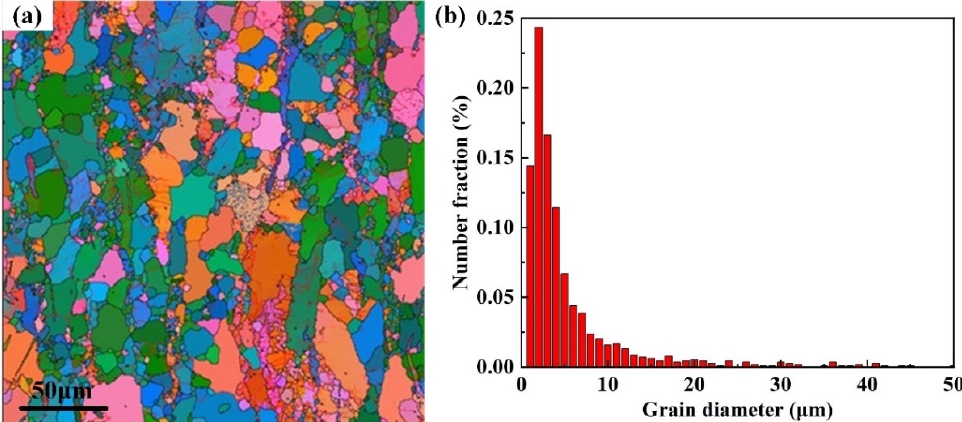
Figure 3. ( a ) EBSD Euler diagram of the original state of ZK61M alloy, and ( b ) Statistic of grain size in test section of ZK61M alloy.